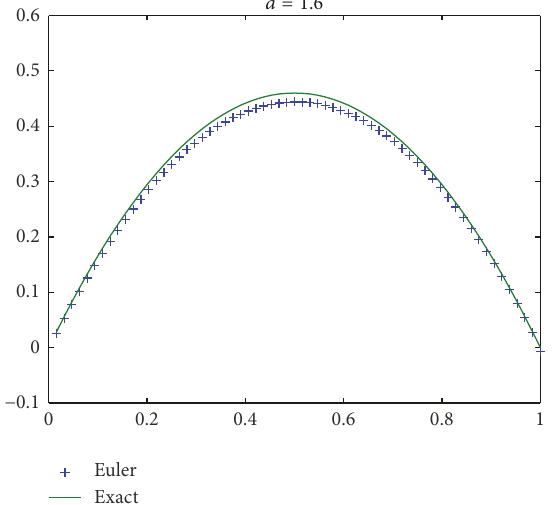
𝛼 = 1.8 , and 𝛼 = 1.6 respectively, with 𝑇 = 1 , 𝛽 = 1.0 and Δ𝑡 = ℎ = 2 −6 . The numerical solution compares well